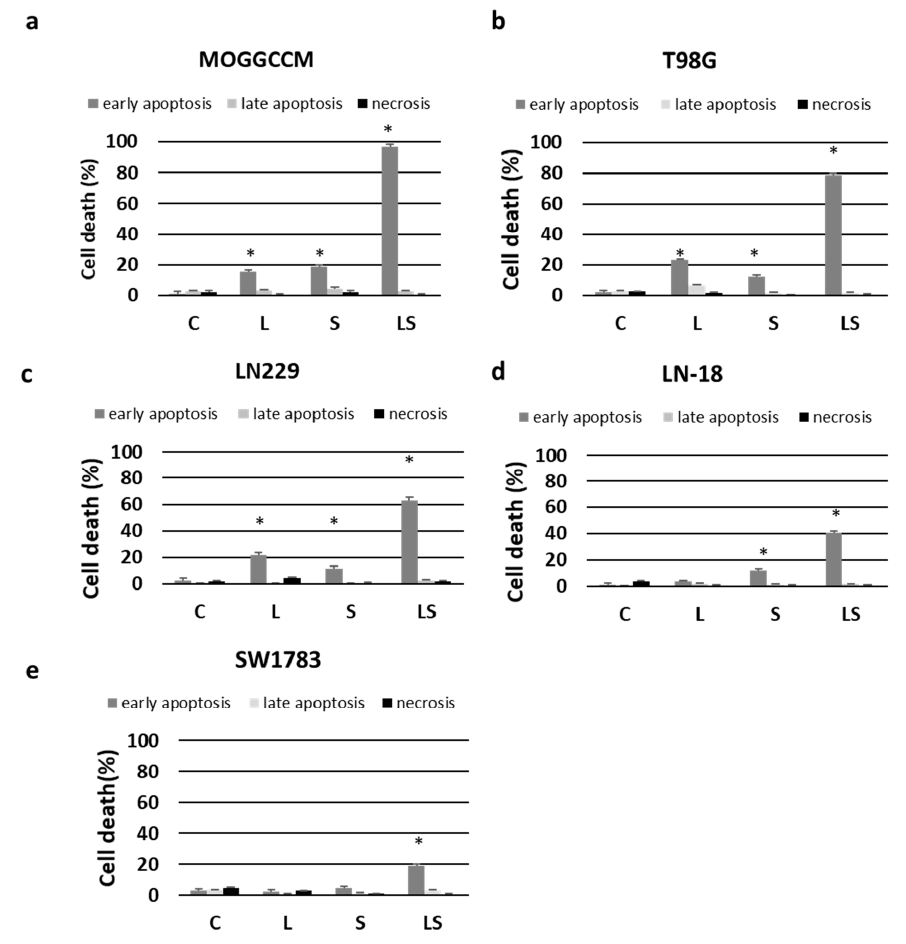
Figure 4. Effect of lensoside A β (L) and sorafenib (S) on apoptosis and necrosis induction in anaplastic astrocytoma (MOGGCCM, LN229, SW1783; a , c , e ) and glioblastoma multiforme cells (T98G, LN-18; b , d ) incubated with the compound for 24 h. Flow cytometry analysis with an Annexin V-FITC detection kit. C—control; * p < 0.01 compared to the control.